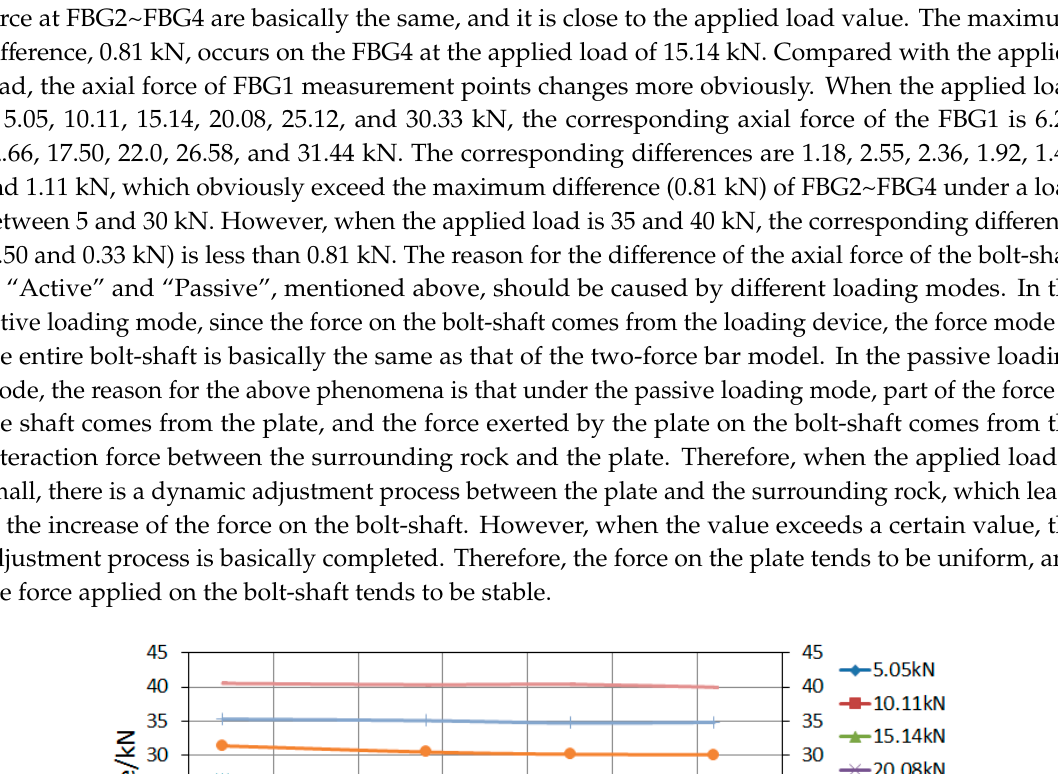
Figure 21. The variation curve of the change rate of the bolt-shaft axial force in “Passive”. As shown in Figure 20, none of the change rates of the bolt-shaft axial force in “Active” are in the area of “large influence” or “medium influence”, and all are located in the “small influence” area.